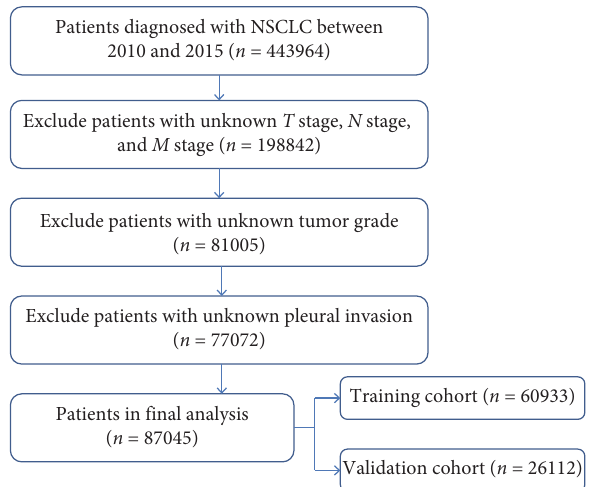
Figure 1: The flowchart of patients included and